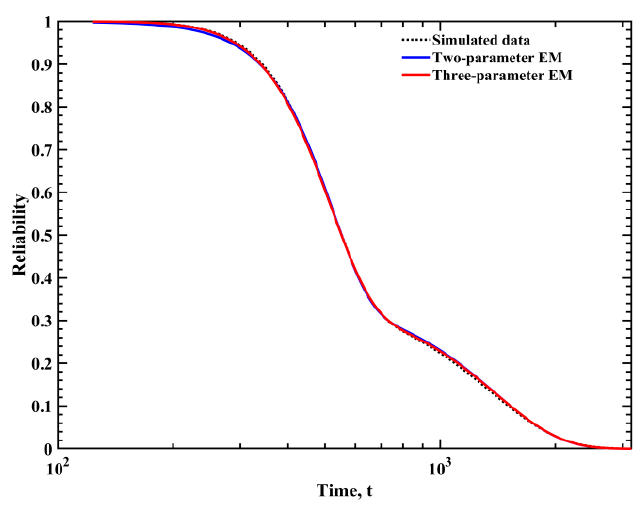
Figure 5. Simulation of fitted reliability functions of failure times.